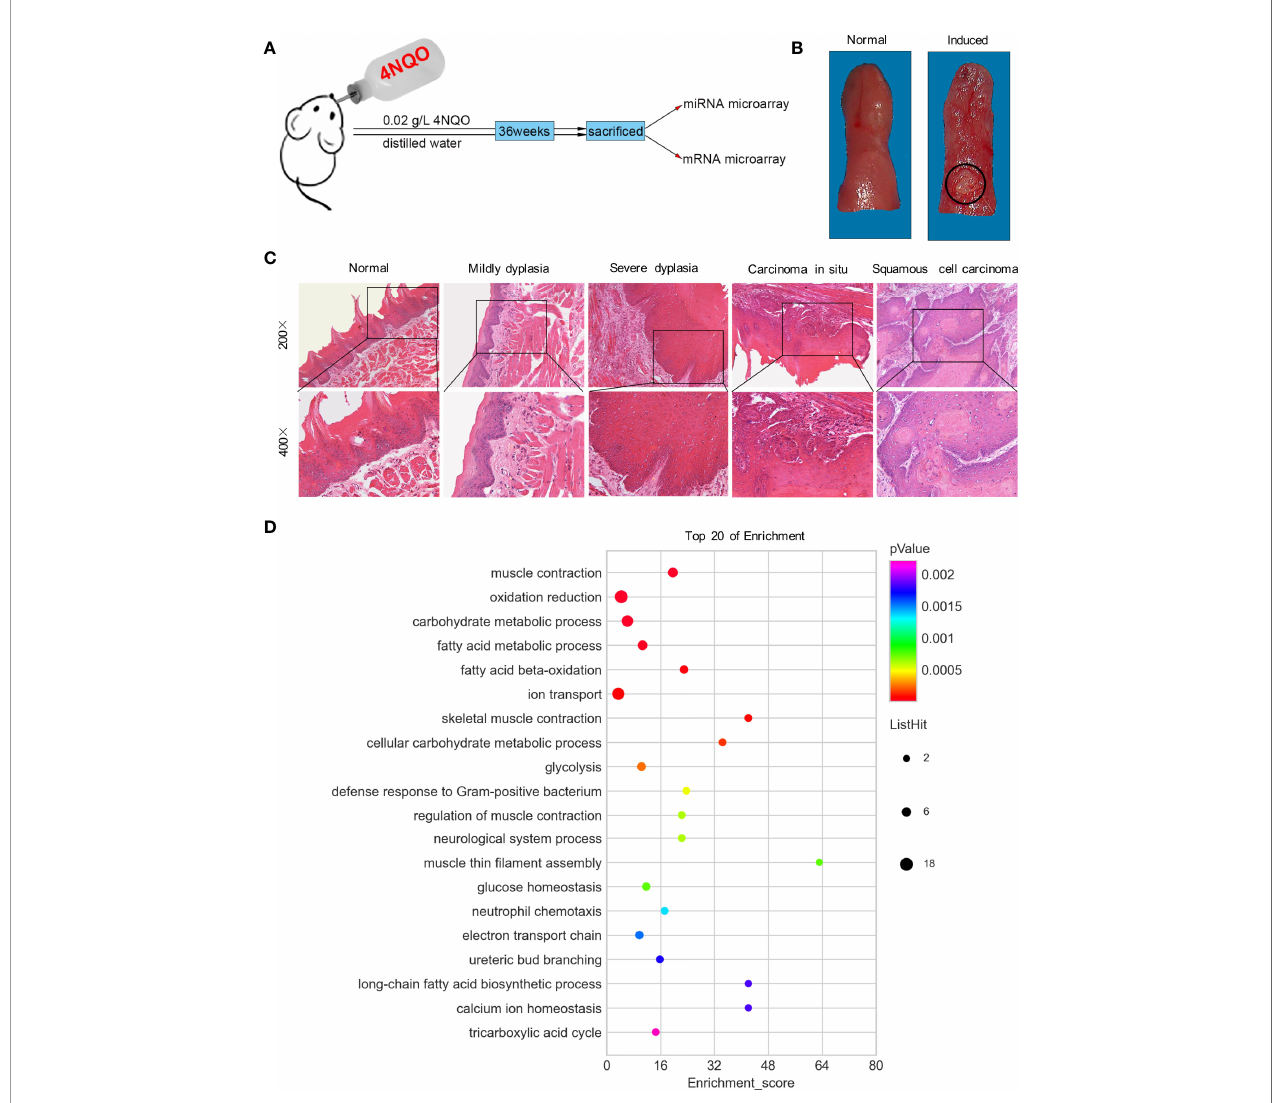
FIGURE 1 | Both macroscopic and microscopic changes in SD rats ’ tongue mucosa. (A) Experimental scheme of SD rats induced by 4NQO for 36 weeks. (B) Photograph of normal tongue (left) and exophytic neoplasm on tongue induced by 4NQO water for 36 weeks (right). (C) H&E staining showed the pathological changes of rat tongues base at different stages. (D) GO analysis of top 20 of functional enrichment based on mRNA